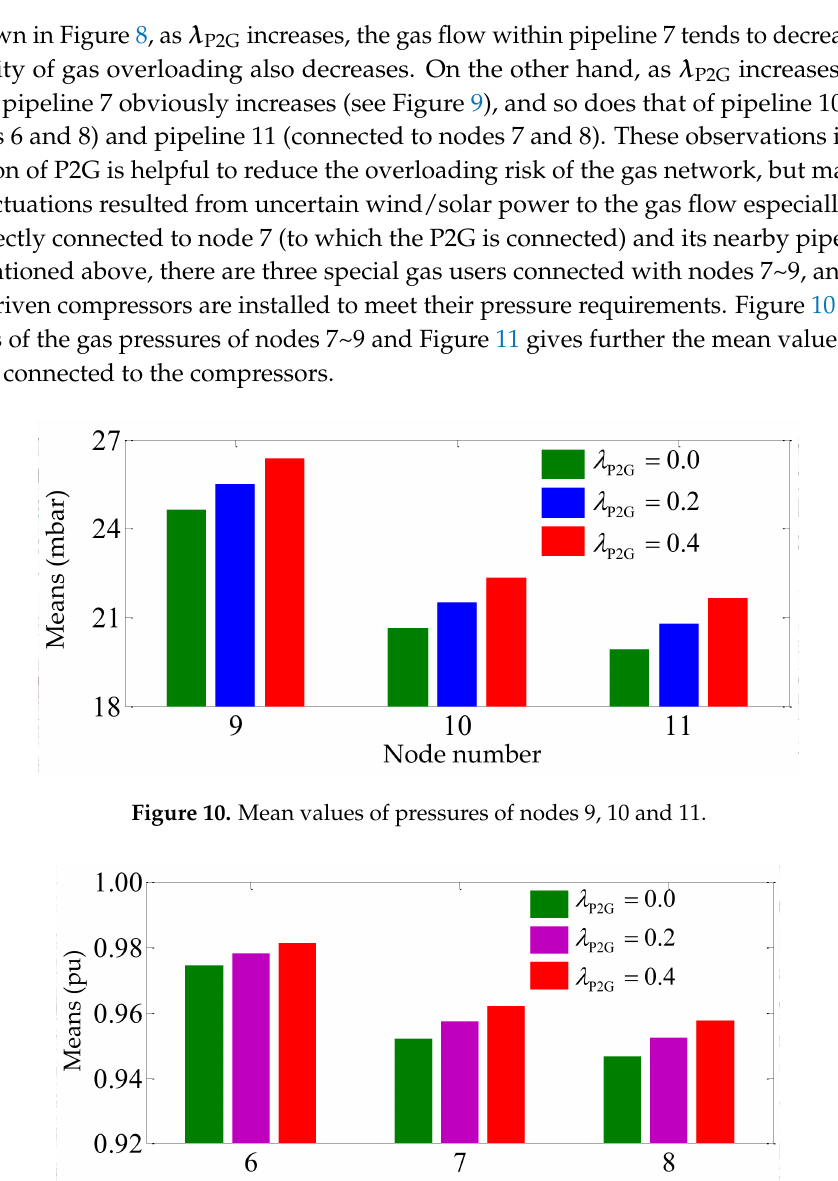
Figure 9. SDs of gas flow within all pipelines in the gas network.